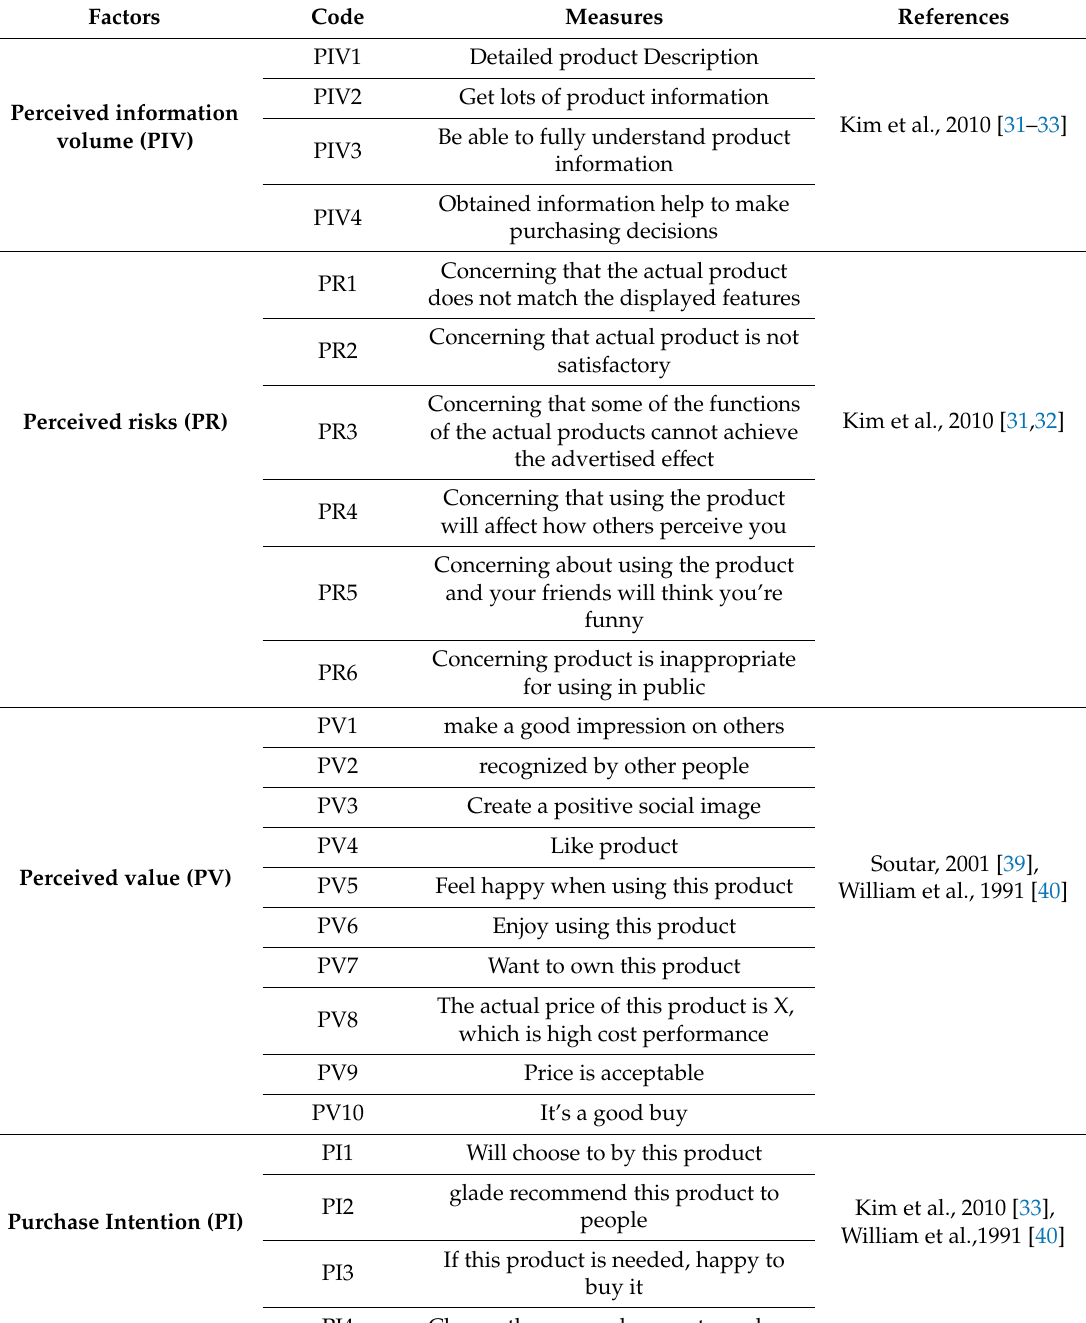
Table 2. Measurements